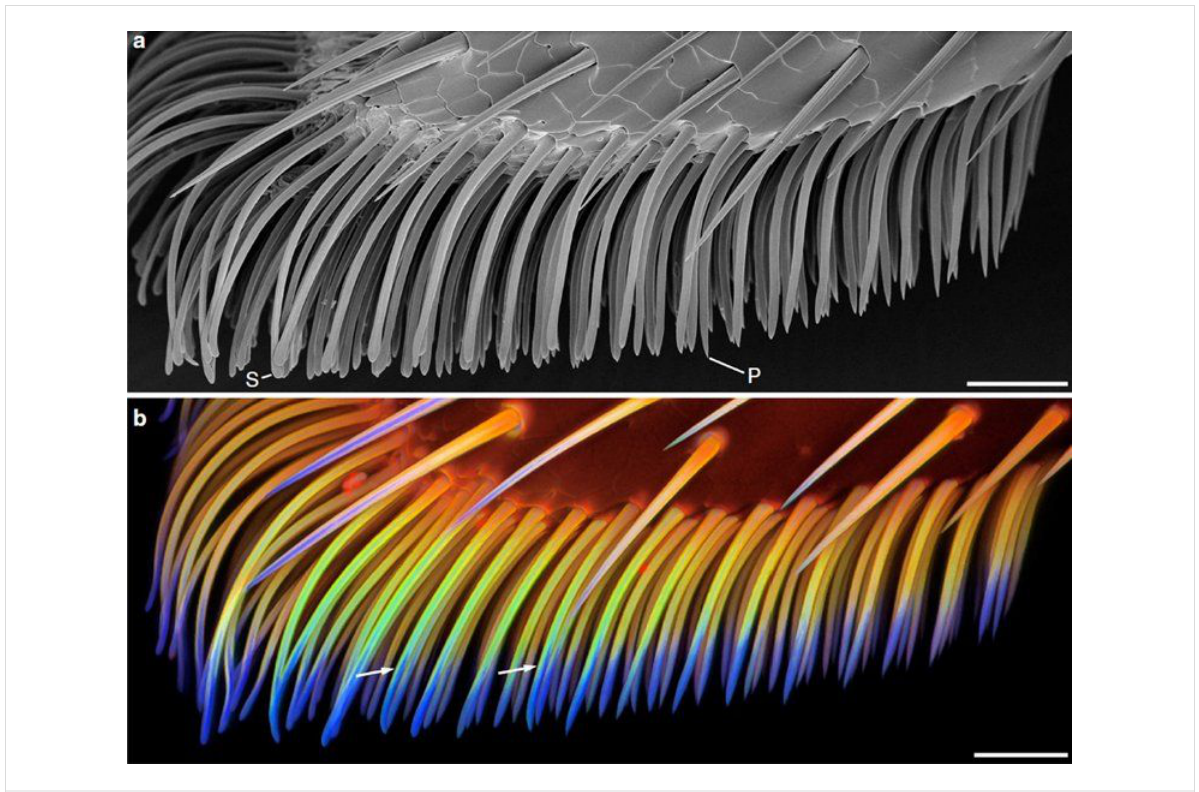
Figure 1: Morphology and material composition of adhesive tarsal setae. Ventral part of the second adhesive pad of a foreleg of a female Coccinella septempunctata , lateral view. (a) Scanning electron micrograph (the specimen was dried using 1-propanol). (b) CLSM maximum intensity projection showing an overlay of the four different autofluorescences mentioned in the text. The arrows indicate the dorso-ventral material gradient in exemplary setae. S, exemplary spatula-like seta; P, exemplary seta with a pointed tip. Scale bars, 25 µm. From [12] (Nature Publishing